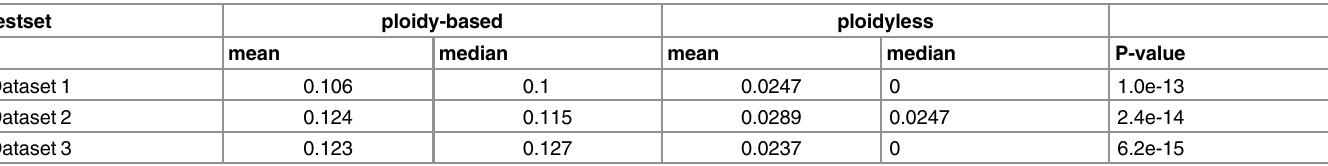
Table 5. Average fraction of unobserved (Steiner) nodes in the generated trees. P-values were generated using a two-sided paired Wilcoxon